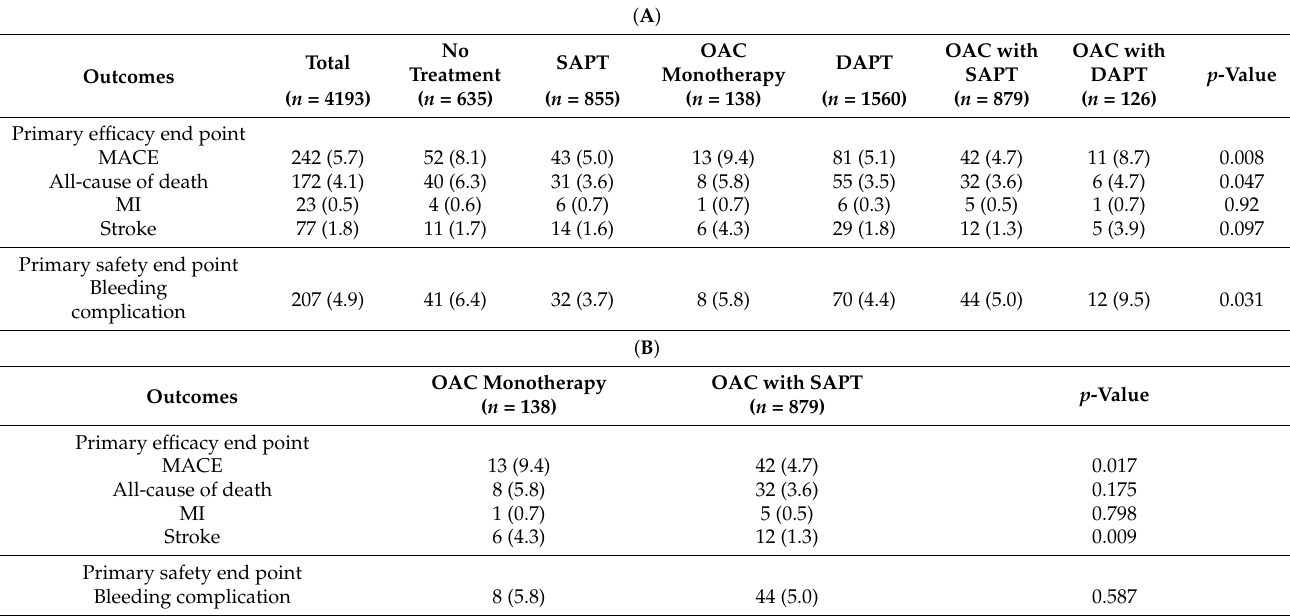
Table 2. 1-year clinical outcomes according to combinations of anticoagulants and antiplatelet agents.